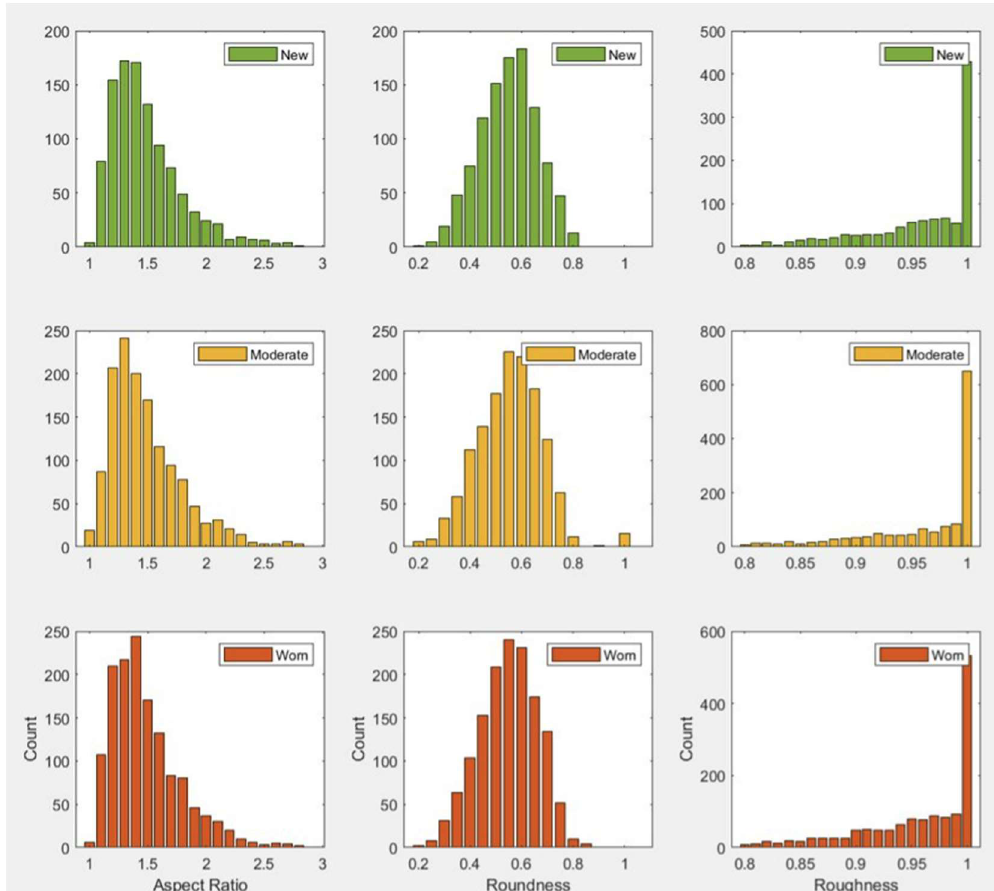
Figure 8. The aspect ratio, roundness, and roughness values calculated and represented in histograms for the suspended respirable particles generated from the three different pick wears.